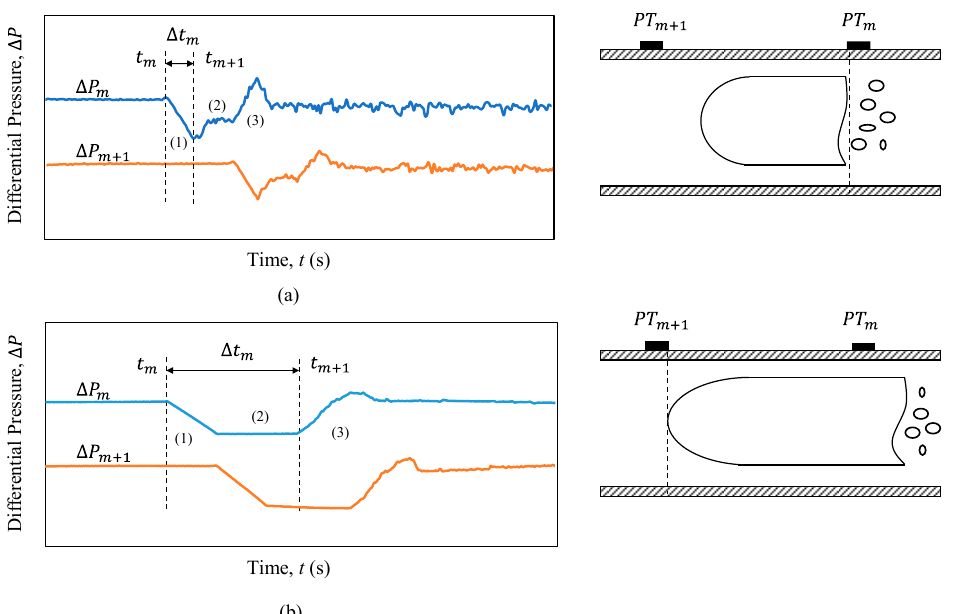
Figure 8. Differential pressure to determine the length of Taylor bubble. ( a ) The length of the Taylor bubble is shorter than the distance of two pressure transducers; ( b ) the length of the Taylor bubble is larger than the distance between two pressure transducers.